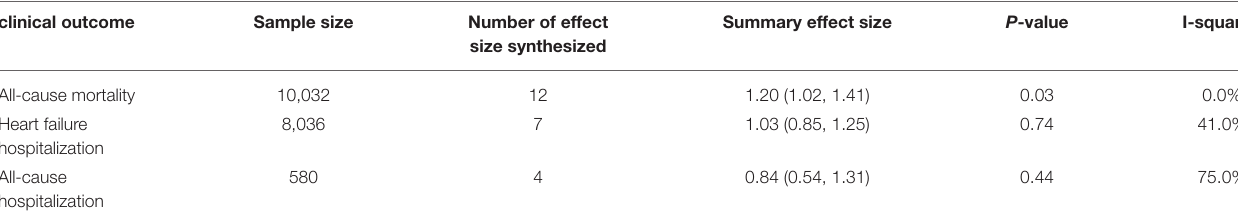
TABLE 2 | Meta-analysis of treatment effect of uric acid -lowering therapies on clinical outcome. clinical